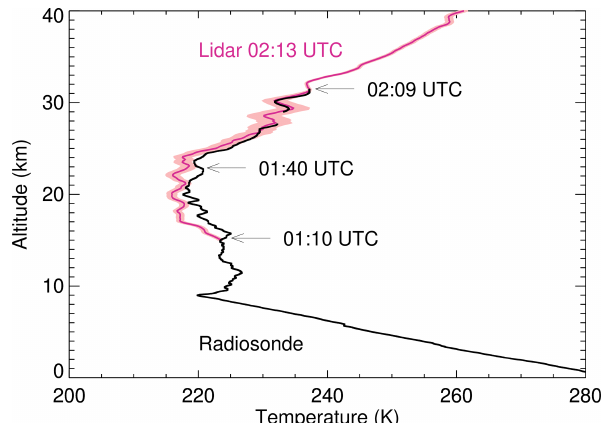
Figure 14. Radiosonde and lidar profile acquired on 16 Novem- ber 2019. The arrows indicate the height of the radiosonde at dif- ferent times. Reception of the radiosonde signal was briefly lost at 28km altitude. The shaded area marks the uncertainty of the lidar